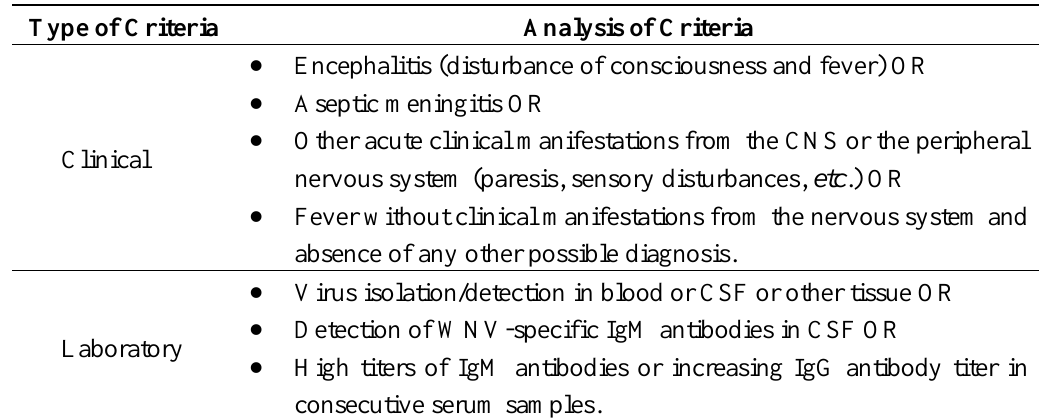
Table 4. Clinical and laboratory criteria for WNV case definition.